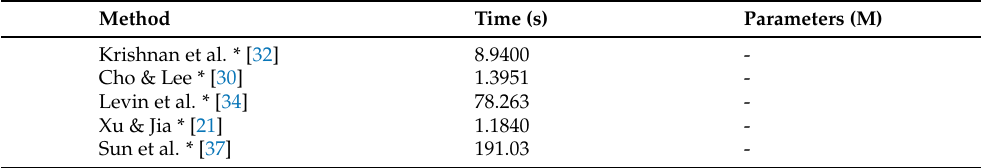
Table 5. Comparison of average inference time on Levin test set [33] and the number of model pa- rameters. * indicates that the method uses the non-blind deconvolution method of [34] to produce the final